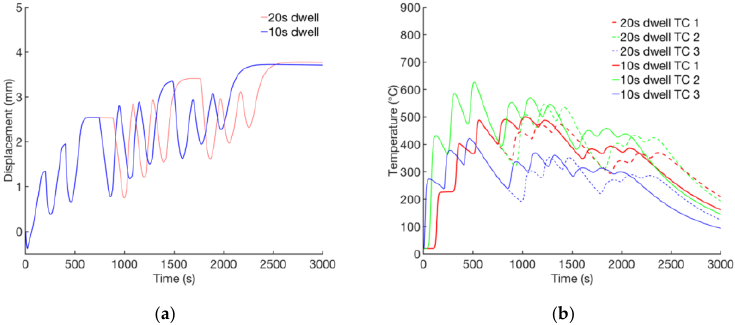
Figure 14. Computed displacement ( a ) and temperature ( b ) for lumping 14 passes for the case with 20 s dwell time between layers compared with a model where the dwell time between layers is reduced to 10 s.